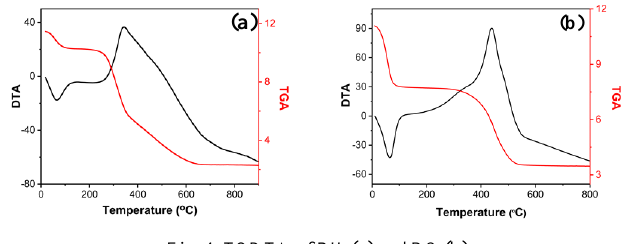
Fig. 4. TGDTA of RH (a) and BC